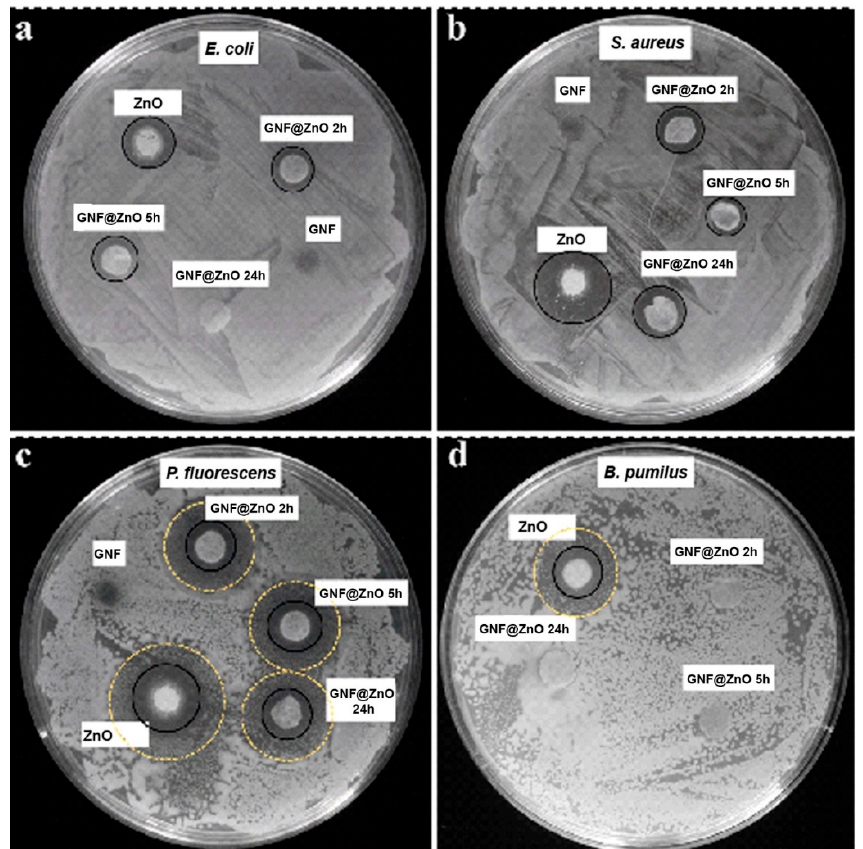
Figure 6. Antibacterial activity of ZnO NPs, GNF, and their composites (GNF@ZnO 2 h, 5 h, 24 h) against E. coli ( a ), S. aureus ( b ) , P. fluorescens ( c ), and B. pumilus ( d ) bacteria strains performed on agar plates. Black circles indicate growth inhibition zones, and yellow dashed circles indicate restricted/limited growth zones.